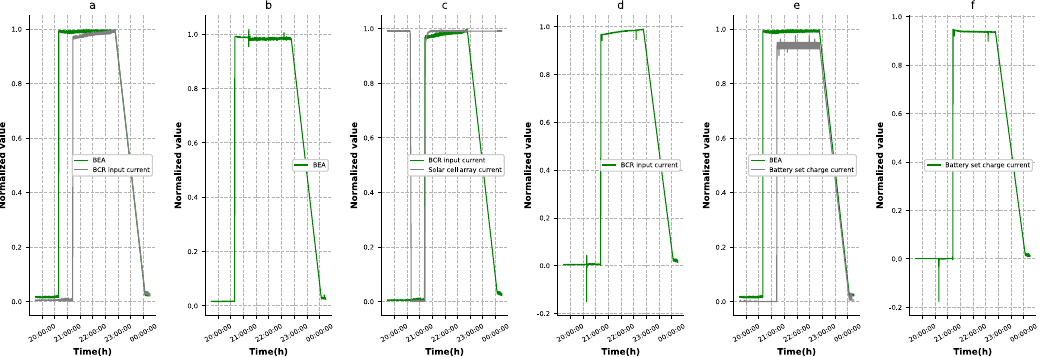
Figure 3. High reconstruction error caused by the interaction between features. ( a ) The BEA signal value and BCR input current. ( b ) The reconstruction result of the BEA signal value. ( c ) The BCR input current and solar cell array current. ( d ) The reconstruction result of the BCR input current. ( e ) The BEA signal value and battery set charge current. ( f ) The reconstruction result of the battery set charge current.